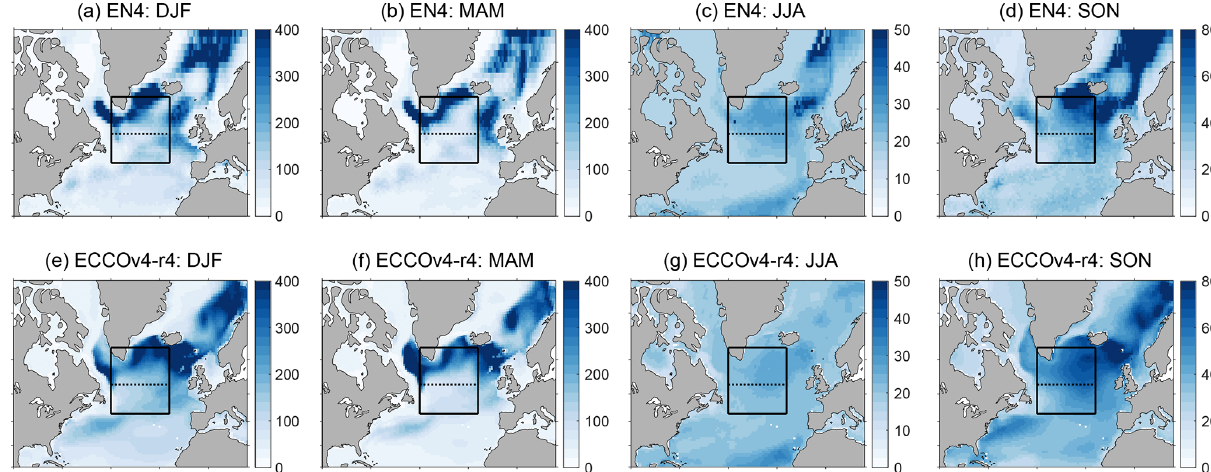
Figure 4. The average seasonal cycle of the North Atlantic MLD (m) from 1992–2015 in the EN4 observations (a–d) and ECCOv4-r4 (e–h) . Note the varying colour scales between seasons. The boxes show the position of the cold blob region, with the dashed line separating the northern and southern